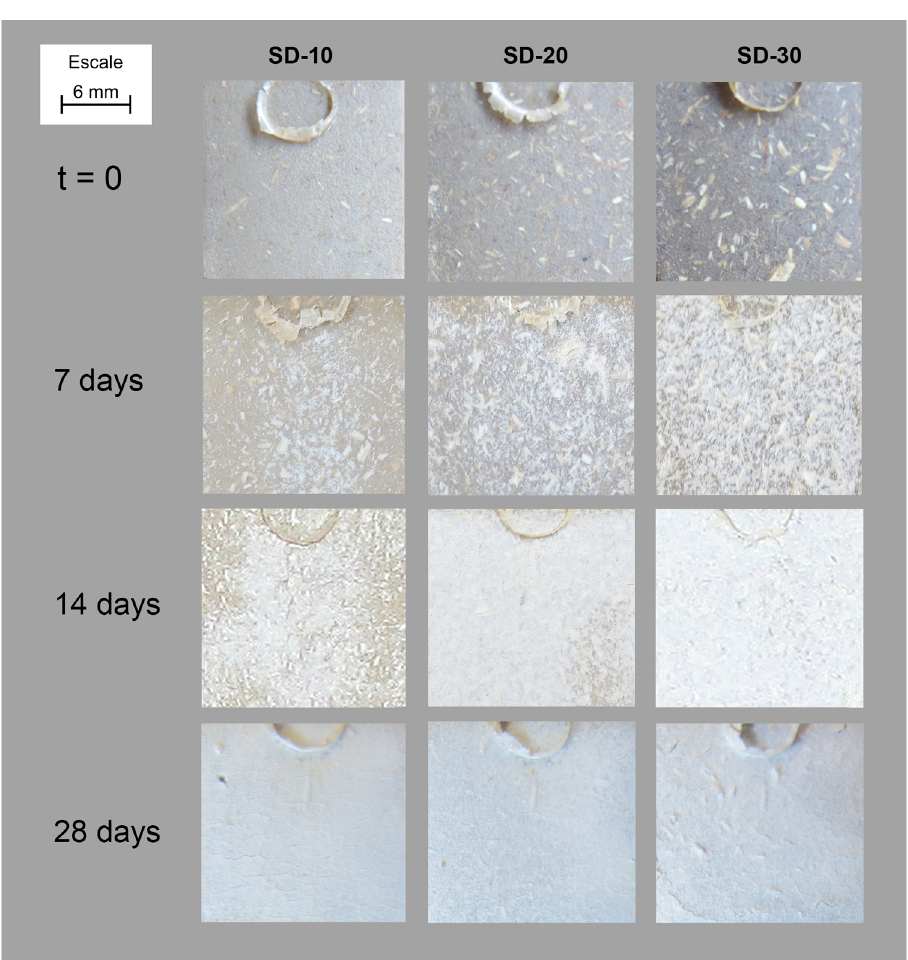
Figure 2. Evolution of the surface of SD ‐ composites inside Xenotest chamber.